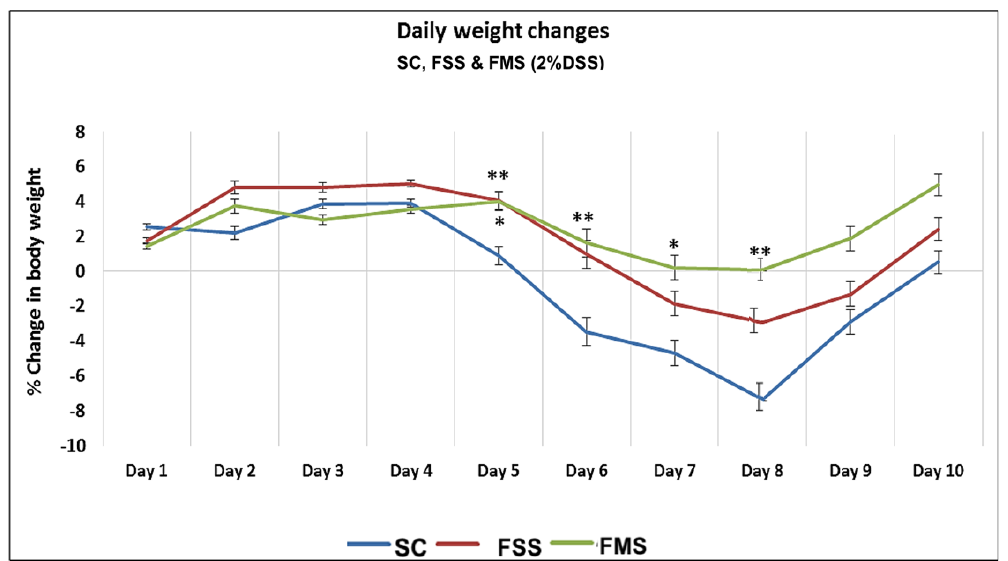
Figure 1. Percentage of weight change associated with acute DSS in mice receiving standard chow (SC) and chow supplemented with ferrous sulphate (FSS) or ferric maltol (FMS). Data are presented as a mean ± standard error of the Figure 1: Percentage of weight change associated with acute DSS in mice mean. Statistical differences were assessed by Kruskal–Wallis test followed by Dunn’s multiple comparison tests (* p < 0.05, receiving standard chow (SC) and chow supplemented with ferrous ** p < 0.01). ( n = 40 ♀